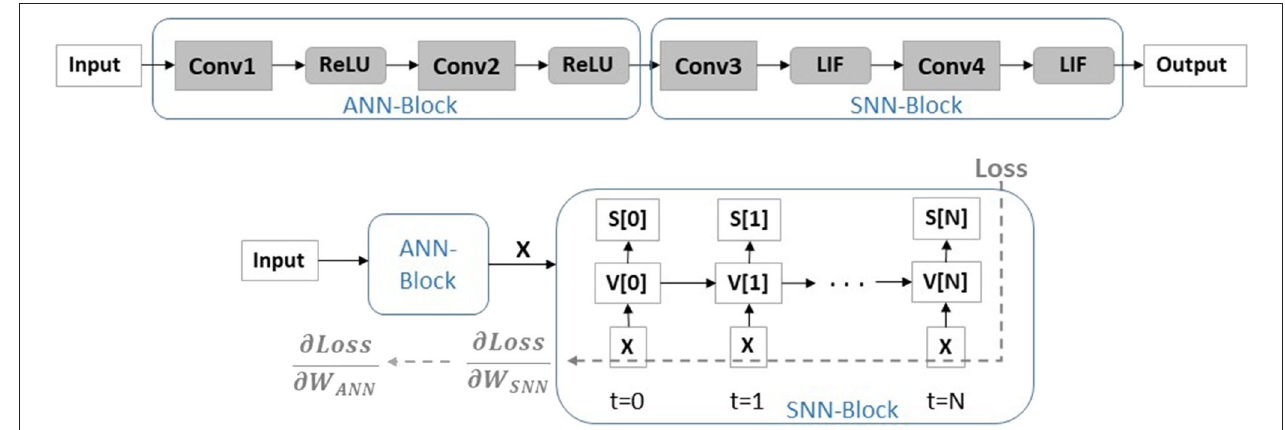
FIGURE 6 | A hybrid network architecture with ReLU activation initially and LIF activation in latter layers for AGD training is shown. During AGD backpropagation, the SNN − block is unrolled and the weight updates are calculated through the unrolled graph over different time-steps using chain-rule. The loss gradient from the SNN − block , ∂ Loss , is then backpropagated through the ANN computational graph to calculate the ANN loss gradients ∂ Loss ∂ W SNN real-valued input X computed from the ANN − block at each